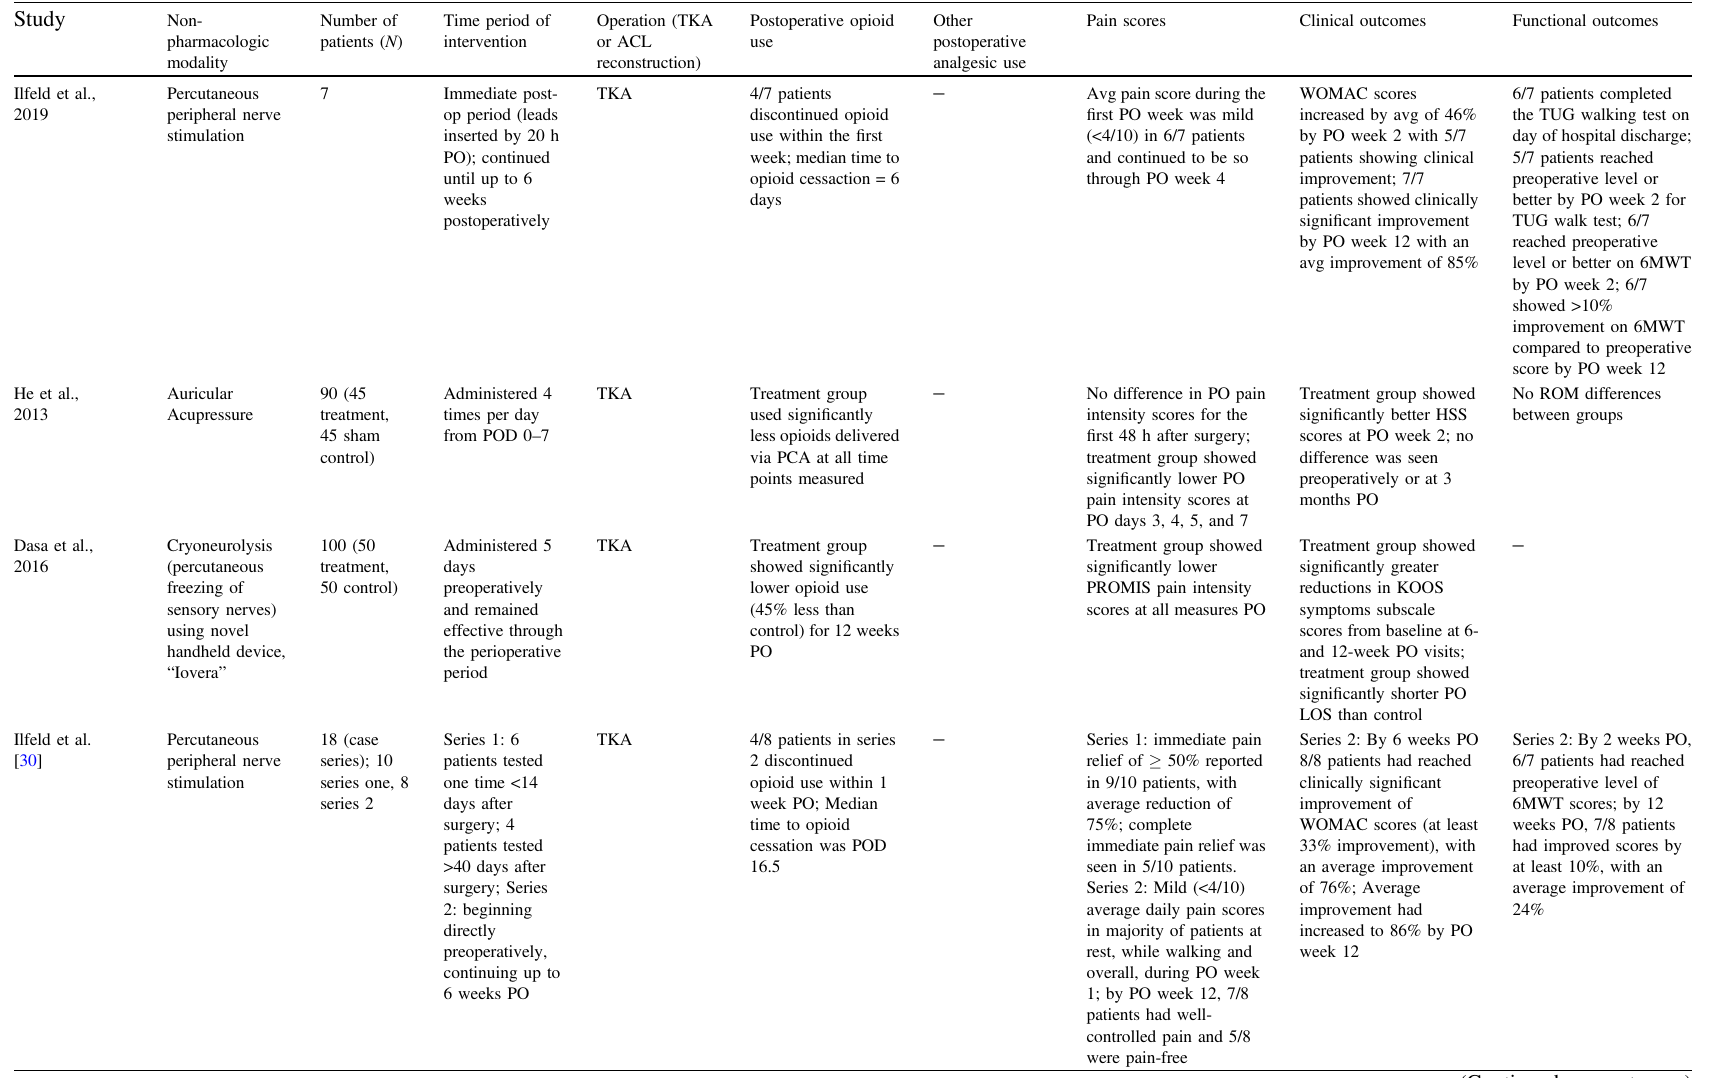
Table 1. Cumulative data for all studies fi tting inclusion